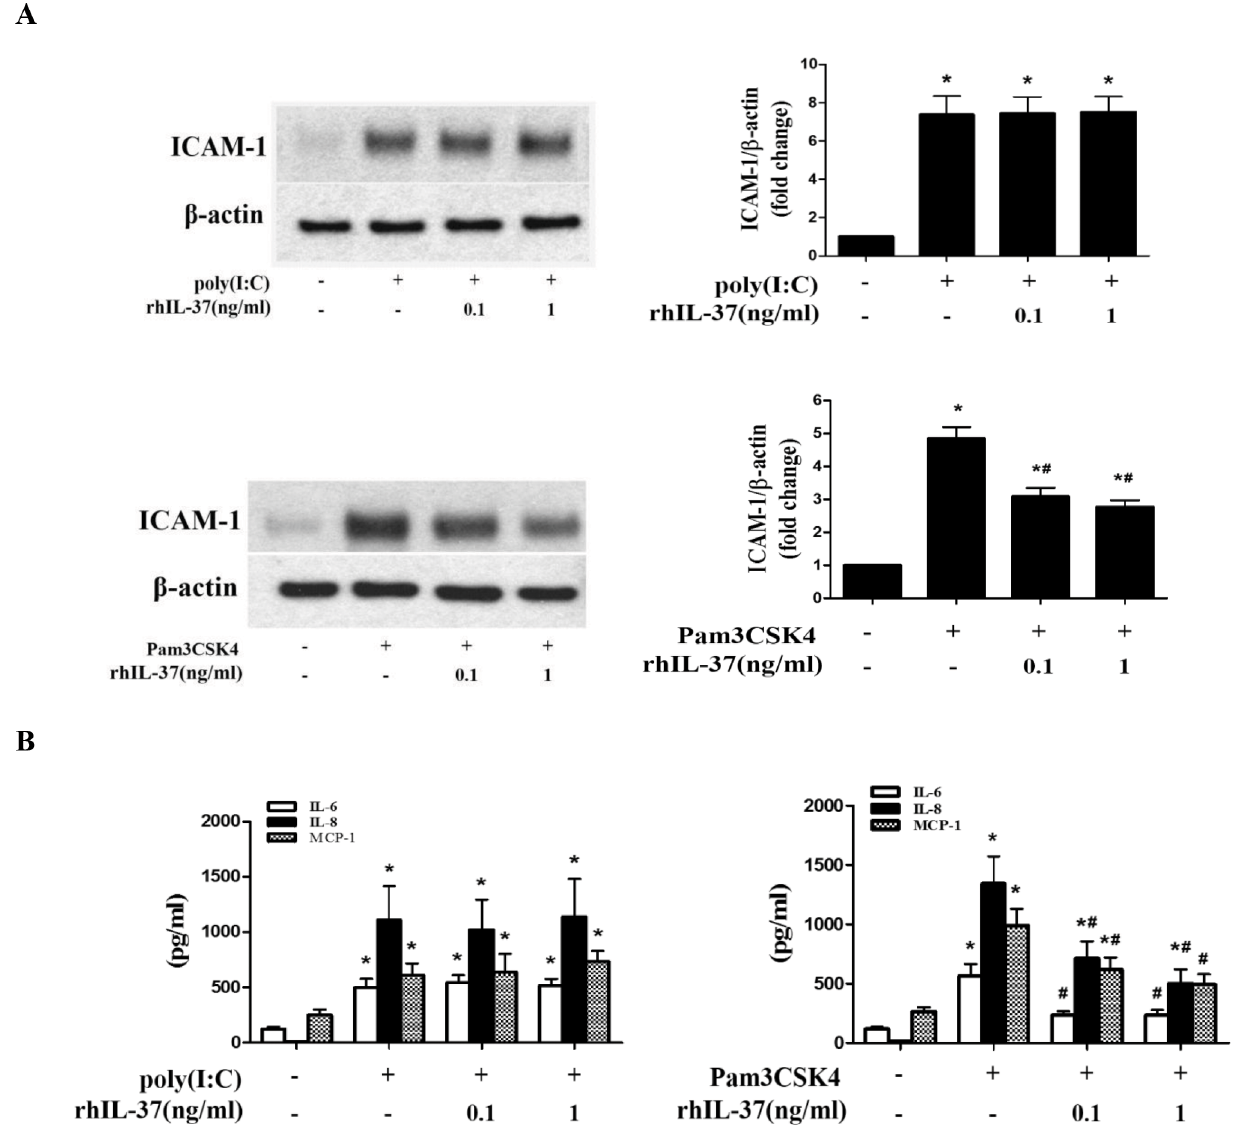
Figure 4. IL-37 attenuates the inflammatory responses to TLR2 stimulation, but has no effect on the responses to TLR3 stimulation. AVICs were treated with poly(I:C) (2.5 μ g/mL) or Pam3CSK4 (0.1 μ g/mL) for 24 h in the presence and absence of IL-37 (0.1 and 1.0